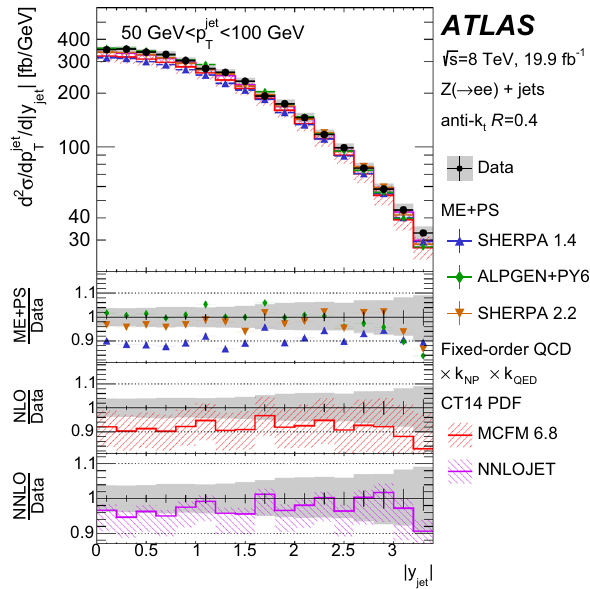
Fig. 7 The double-differential Z + jets production cross-section as a Fig. 8 The double-differential Z + jets production cross-section as a < 50GeV range. The data are < 100GeV range. The data are function of | y jet | in the 25GeV < p jet function of | y jet | in the 50GeV < p jet T T compared with the Sherpa v. 1.4, Sherpa v. 2.2 and Alpgen+Pythia compared with the Sherpa v. 1.4, Sherpa v. 2.2 and Alpgen+Pythia partonshowerMCgeneratorpredictionsandwiththefixed-ordertheory partonshowerMCgeneratorpredictionsandwiththefixed-ordertheory predictions.Thefixed-ordertheorypredictionsarecorrectedforthenon- predictions.Thefixed-ordertheorypredictionsarecorrectedforthenon- perturbativeandQEDradiationeffects.Thefixed-order calculationsare perturbativeandQEDradiationeffects.Thefixed-ordercalculationsare performed using the CT14 PDF. The total statistical uncertainties are performed using the CT14 PDF. The total statistical uncertainties are shown with error bars. The total uncertainties in the measurement and shown with error bars. The total uncertainties in the measurement and in the fixed-order theory predictions are represented with shaded bands. in the fixed-order theory predictions are represented with shaded bands. The total uncertainty in the measurement is the sum in quadrature of The total uncertainty in the measurement is the sum in quadrature of the statistical and systematic uncertainties except for the luminosity the statistical and systematic uncertainties except for the luminosity uncertainty of 1.9%. The total uncertainty in the fixed-order theory uncertainty of 1.9%. The total uncertainty in the fixed-order theory predictions is the sum in quadrature of the effects of the PDF, scale, and predictions is the sum in quadrature of the effects of the PDF, scale, and α α S uncertainties, and the uncertainties from the non-perturbative and S uncertainties, and the uncertainties from the non-perturbative and QED radiation corrections. Lower panels show the ratios of predictions QED radiation corrections. Lower panels show the ratios of to data